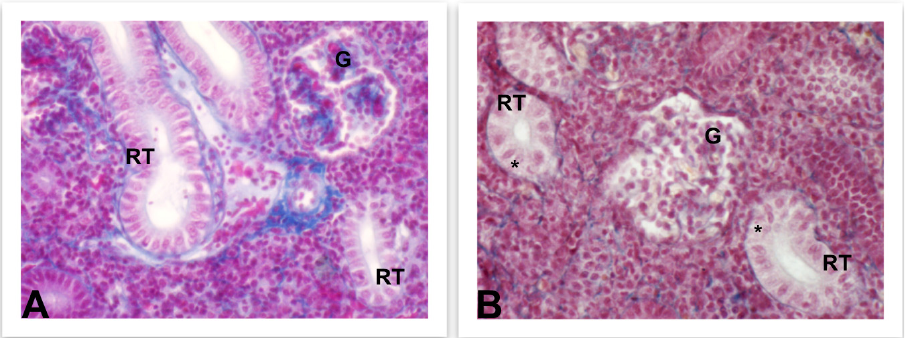
Figure 6. Light micrographs of the kidney of Anguilla anguilla . Mallory staining. ( A ) Control and ( B ) exposed specimens. In exposed specimens, the renal tubules (RT) showed nuclear alterations (*) and the structure of glomerulus (G) was disorganized. Magnification: 400×.